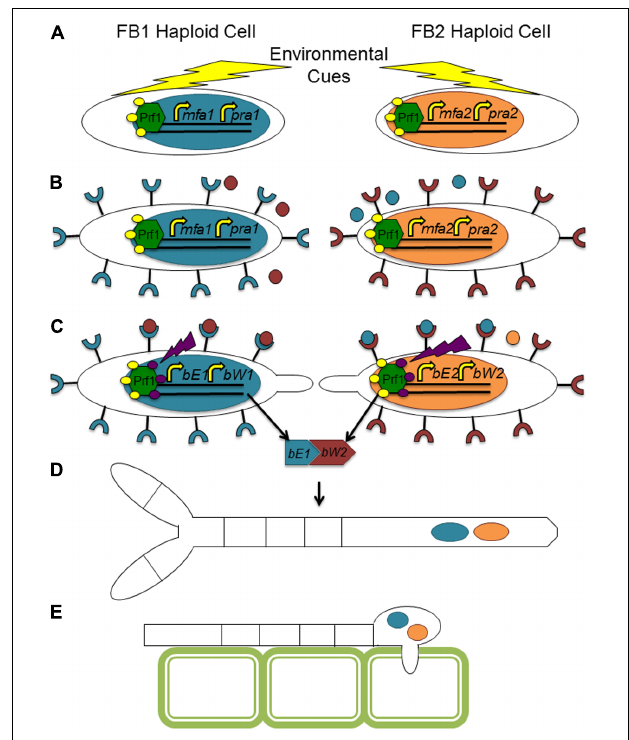
FIGURE 5 | Mating in Ustilago maydis . (A) An initial environmental cue, which may be from the plant or involve nutrient limitation, results in the initial phosphorylation of Prf1. (B) Prf1 binds to a response element in the a mating type loci, resulting in increased expression of the pheromone and pheromone receptor in both types of haploid cells. (C) Interaction of the pheromone with the receptor on the cell of opposite mating type results in additional phosphorylation of Prf1. Prf1 phosphorylated by both pathways then binds to response elements within the b mating type locus, leading to increased expression of the homeodomain proteins. Additionally, interaction of pheromone and receptor results in the growth of conjugation tubes from each cell toward each other. (D) Creation of a homeodomain heterodimer comprised of bE and bW from different allelles results in the formation of an infection dikaryon. (E) This dikaryon is able to establish infection within the host, although fusion of the nuclei does not occur during infection until teliospore formation, just prior to release from the infected plant